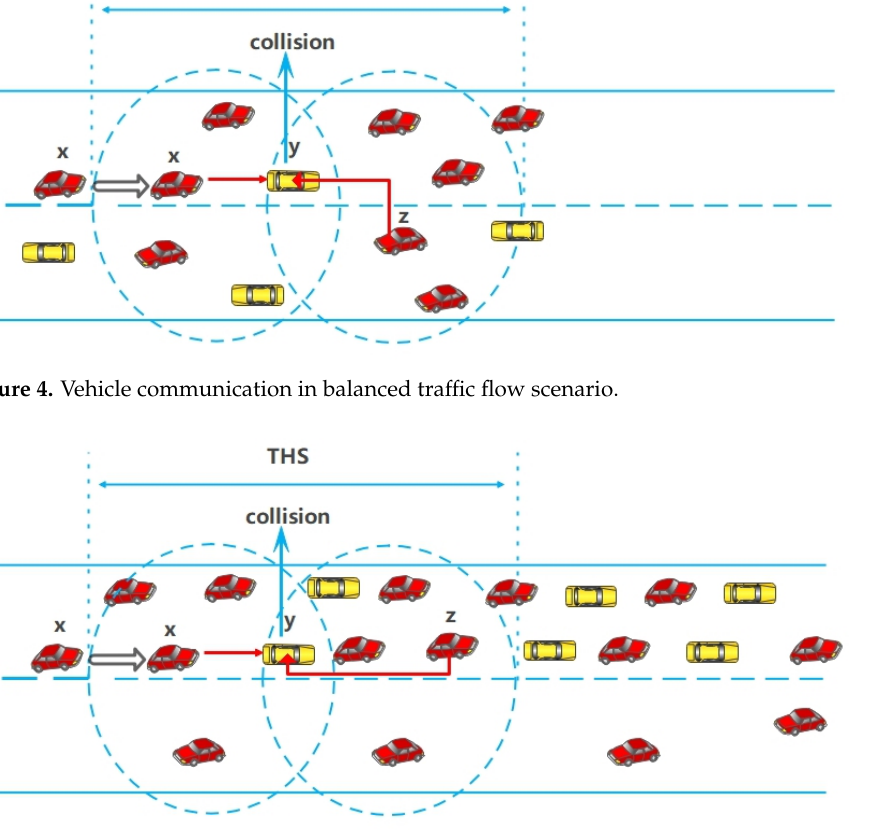
Figure 5. Vehicle communication in unbalanced traffic flow